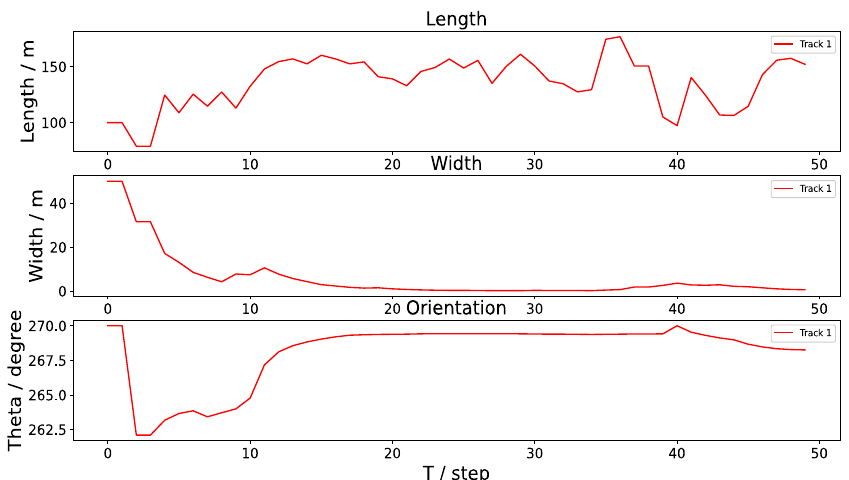
Figure 18. Estimation of the single target’s size and azimuth.